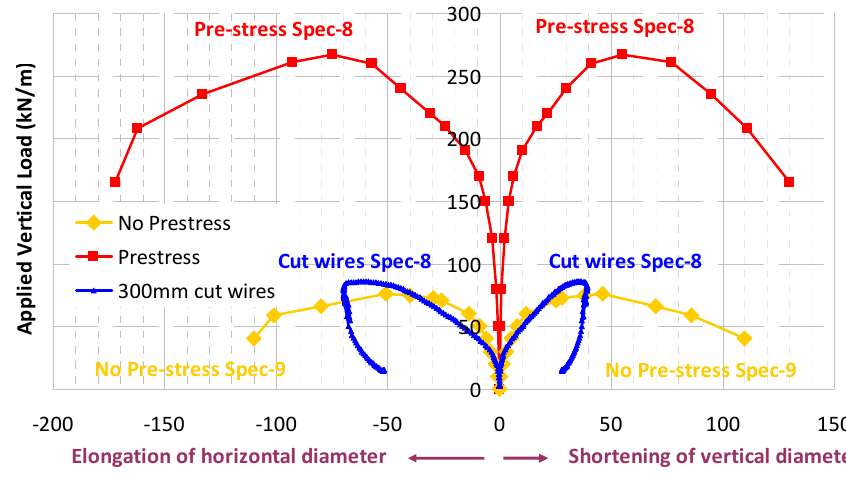
Figure 22. Measured response of Specimen 8 with 16 prestressing wires neutralized by cutting.